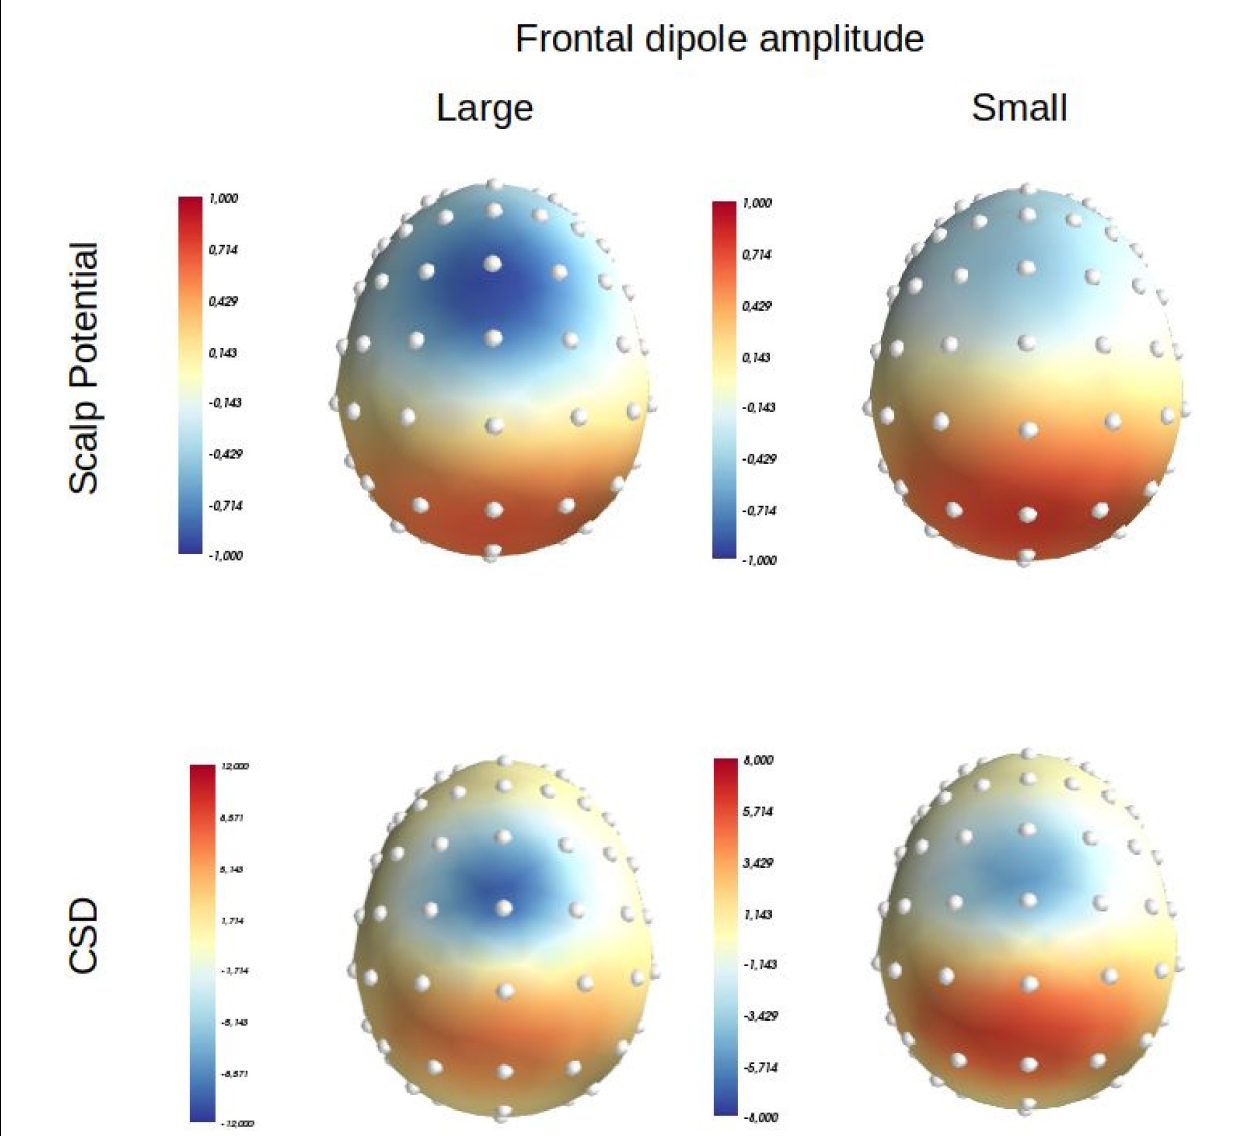
FIGURE 1 | Scalp potential (average reference) and Laplacian (or Current Source Density: CSD) distributions produced at scalp level by a positive medial parietal dipolar source positioned at: x = 0; y = –30, z = 35 (orientation: x = 0, y = –0.4, z = 0.4) in MNI coordinates,and a medial frontal source positioned at: x = 0, y = 0, z = 50 (orientation: x = 0, y = 0.1, z = 1) in MNI coordinates. Left panel: the intensity of the parietalsource is set at 40 mA/m3 and that of the frontal one at –20 mA/m3. Right, panel: the intensity of the parietal source is set at 40 mA/m3 and that of the frontal one at –10 mA/m3 [adapted from Vidal et al.